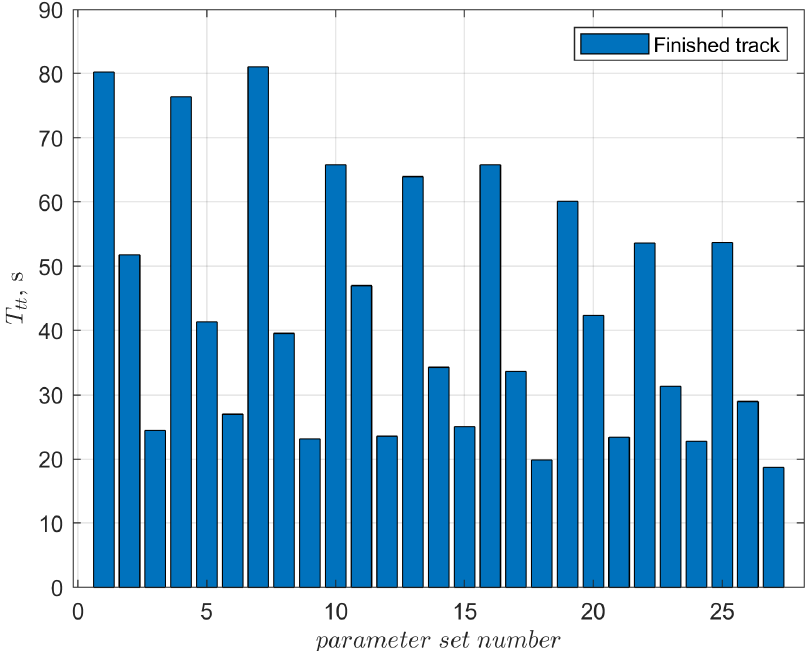
Figure 19. Time needed to path completion for the specified parameter set number—track